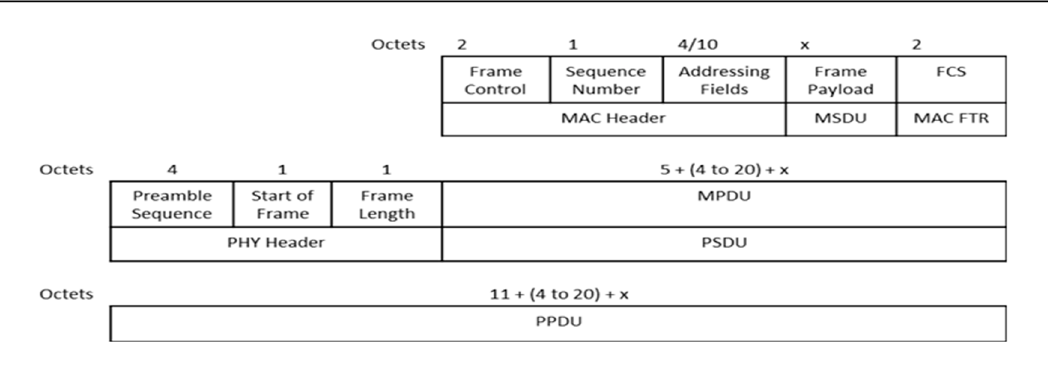
Figure 4. Frame format (IEEE 802.15.4).